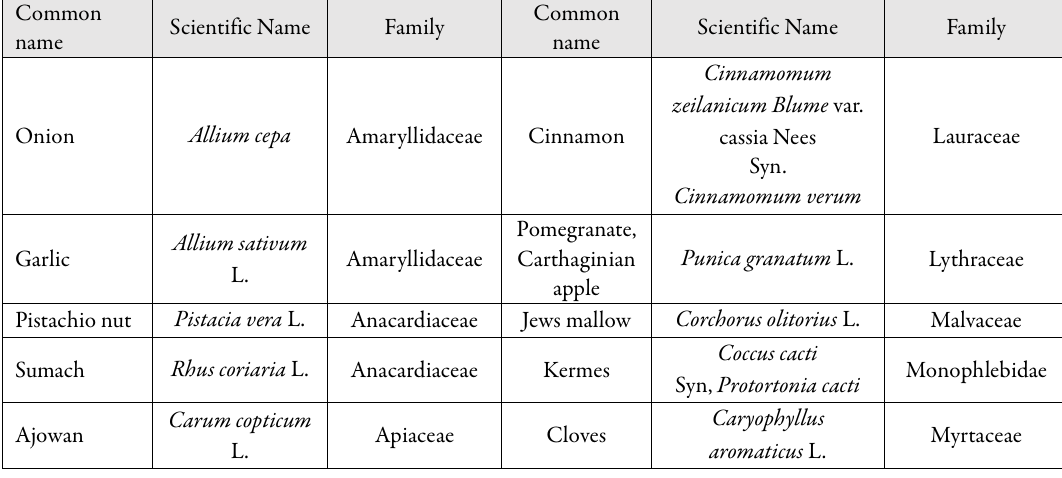
Table 10. Medicinal herbs with hepatoprotective/hepatotherapeutic effects which were mentioned